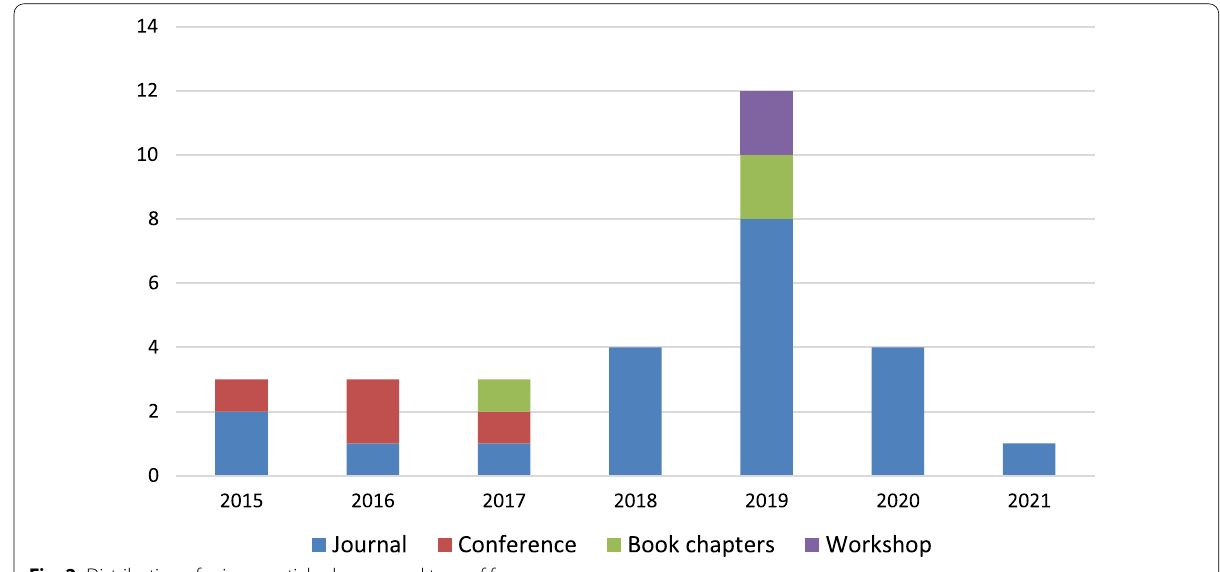
Fig. 2 Distribution of primary articles by year and type of